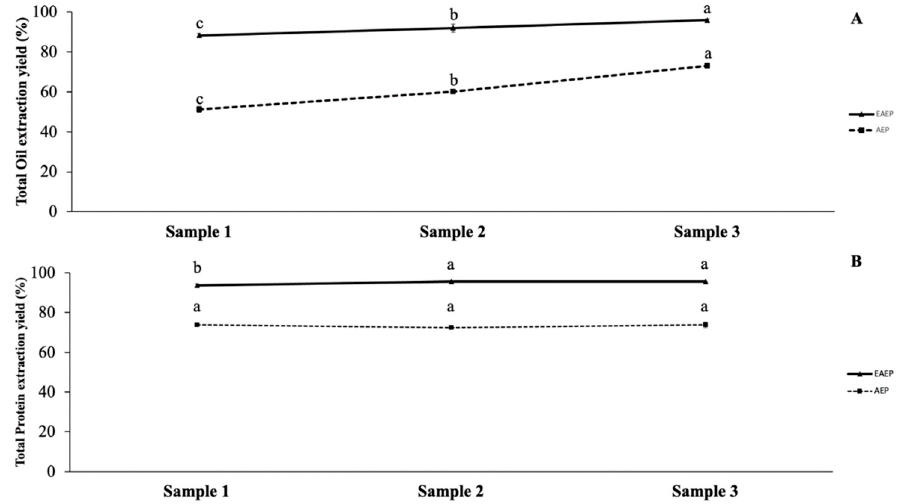
Figure 5. Total oil ( A ) and protein ( B ) extraction yields for the three samples composing each extraction run. Different letters indicate statistically significant differences by one-way ANOVA followed by Tukey’s test at p < 0.05.